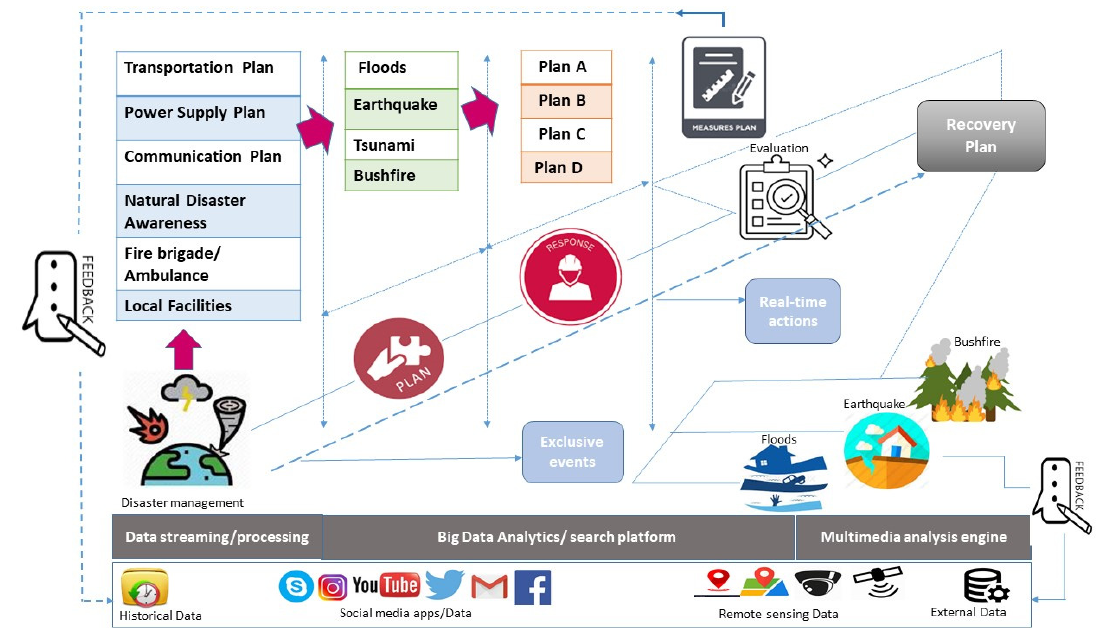
Figure 14. Big data utilization for disaster risk management.